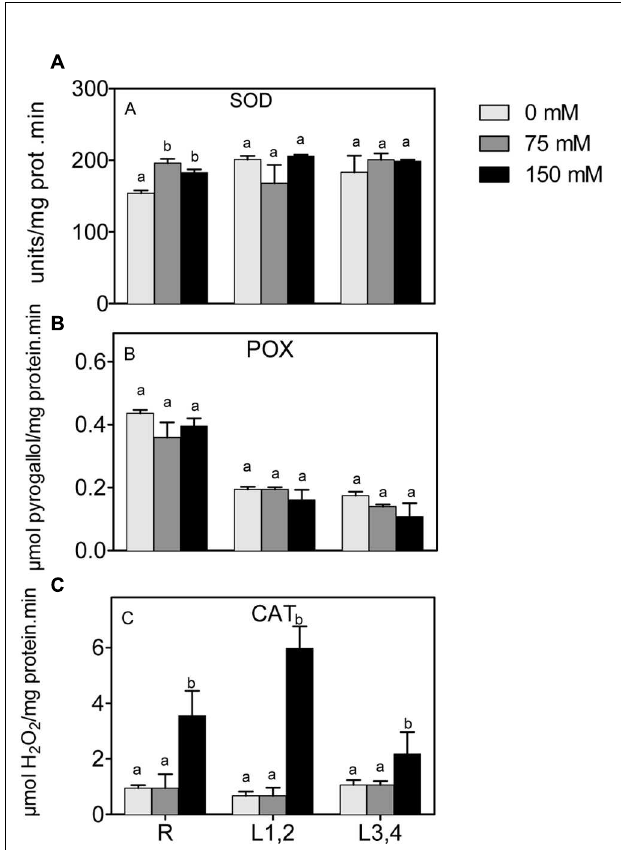
FIGURE 5 | Effect of different salinity levels on superoxide dismutase (A), peroxidase (B), and catalase (C) activities of root (R), mature leaf pair (L1,2), and young leaf pair (L3,4) of 3 weeks old maize seedlings. Values are means of at least three replicates and significant differences between means, as determined by Duncan test ( P < 0.05), are indicated by different